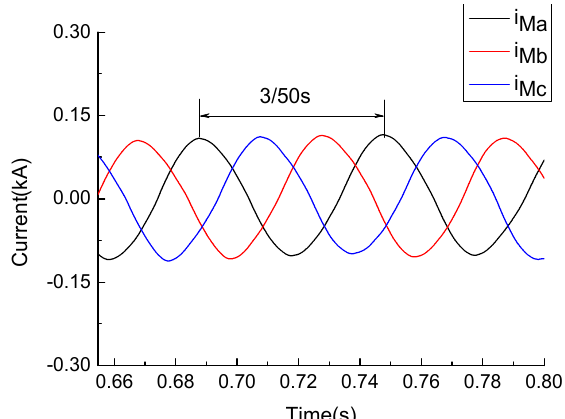
Figure 3. Secondary side system current waveforms.